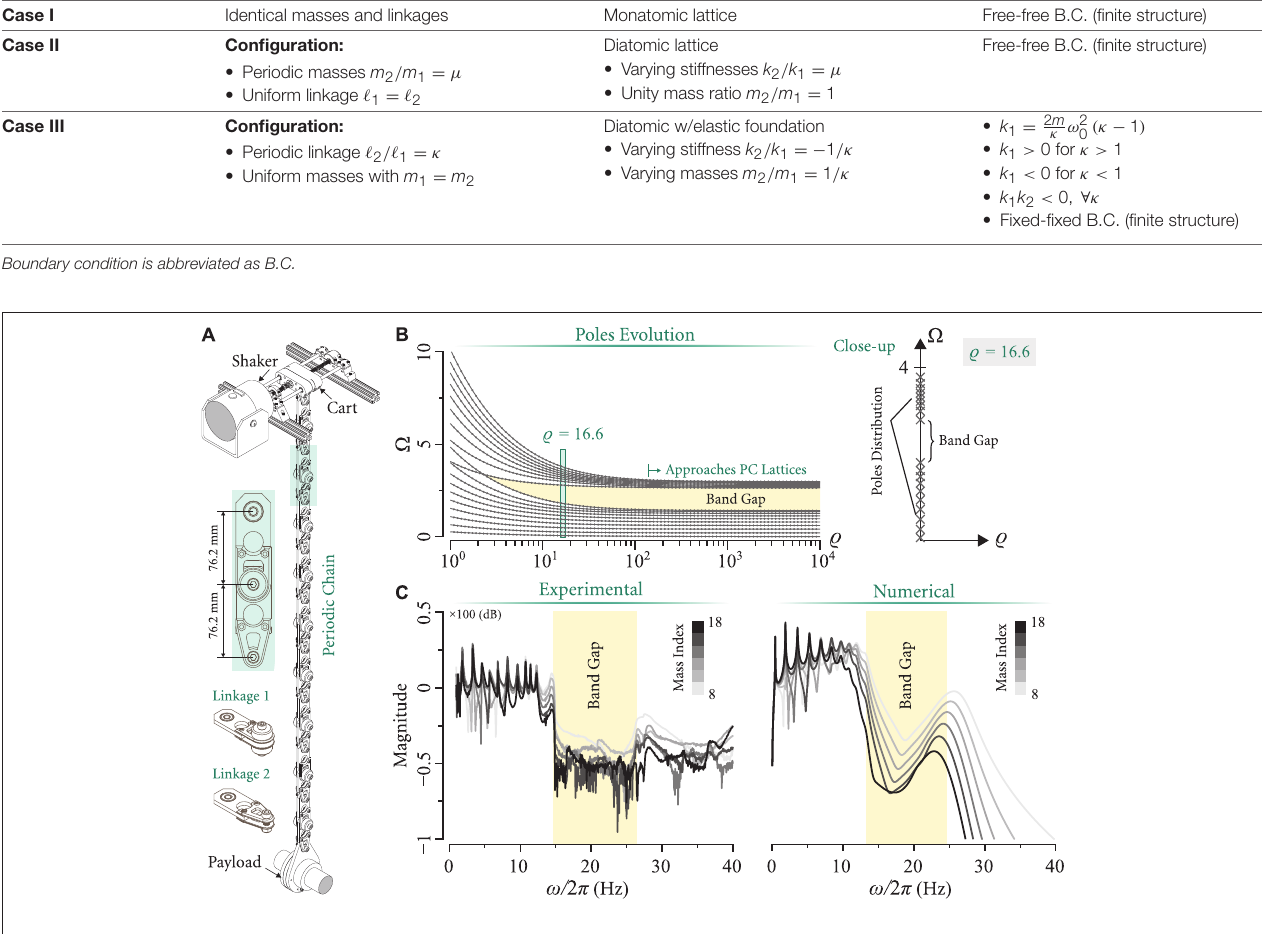
16.6 (value used in the experimental testing). (C) Experimental and = 8 with respect to the cart for a frequency sweep up to 40 Hz. =